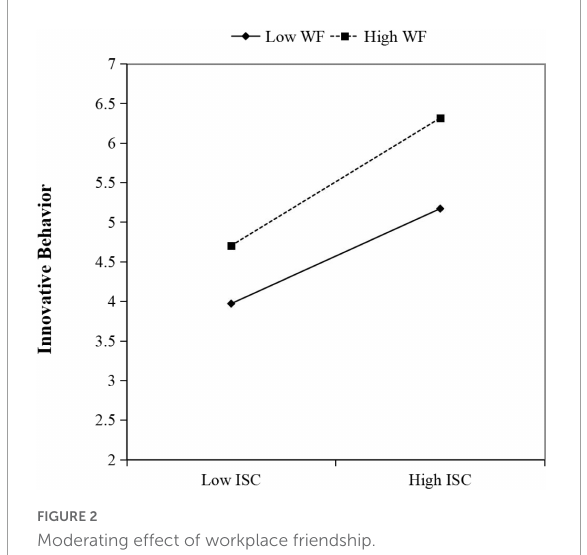
FIGURE2 Moderating effect of workplace